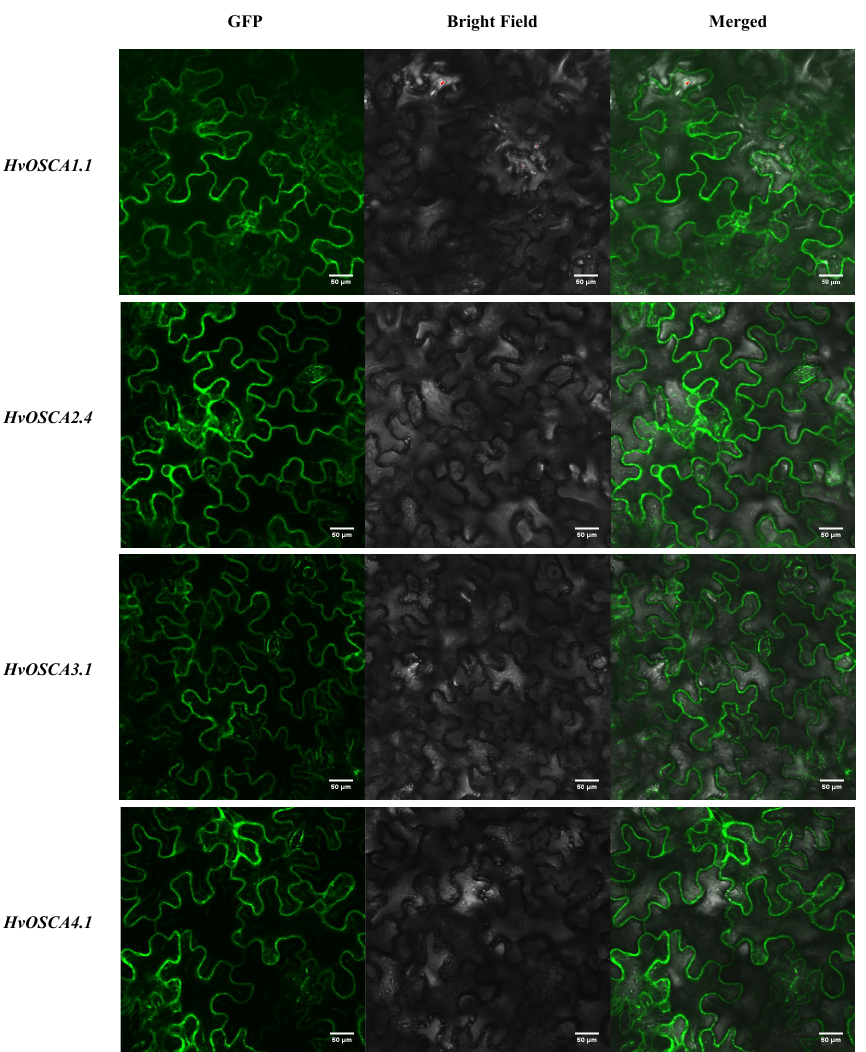
Figure 8. Subcellular localization of four recombinant CaMV35S: HvOSCA -GFP HvOSCA protein fusions transiently expressed in tobacco leaf